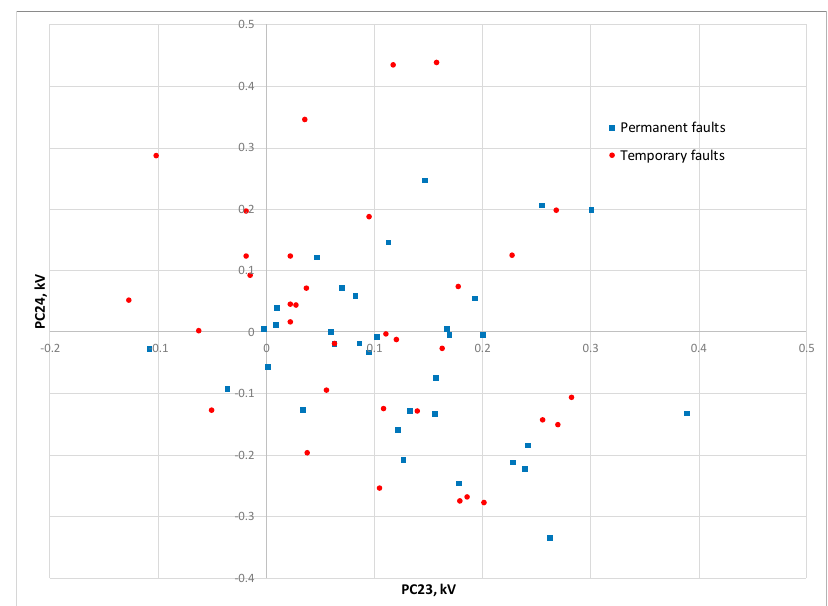
Figure 10. Permanent and temporary faults in the twenty-third and twenty-fourth subspace of PCs.